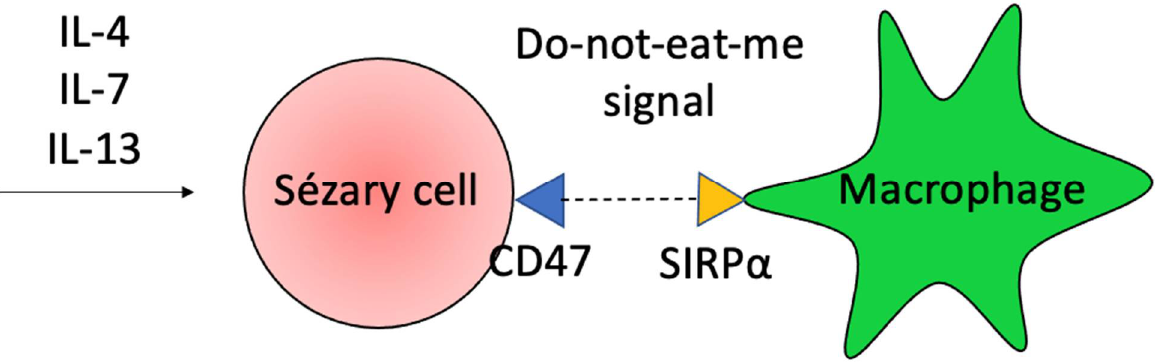
Figure 6. Do-not-eat-me signal. The Th2 microenvironment stimulates the expression of CD47 on the Sézary cell surface. It binds to SIRPα on macrophages and prevents phagocytosis, contributing S é zary cell surface. It binds to SIRP α on macrophages and prevents phagocytosis, contributing to to tumor escape. tumor